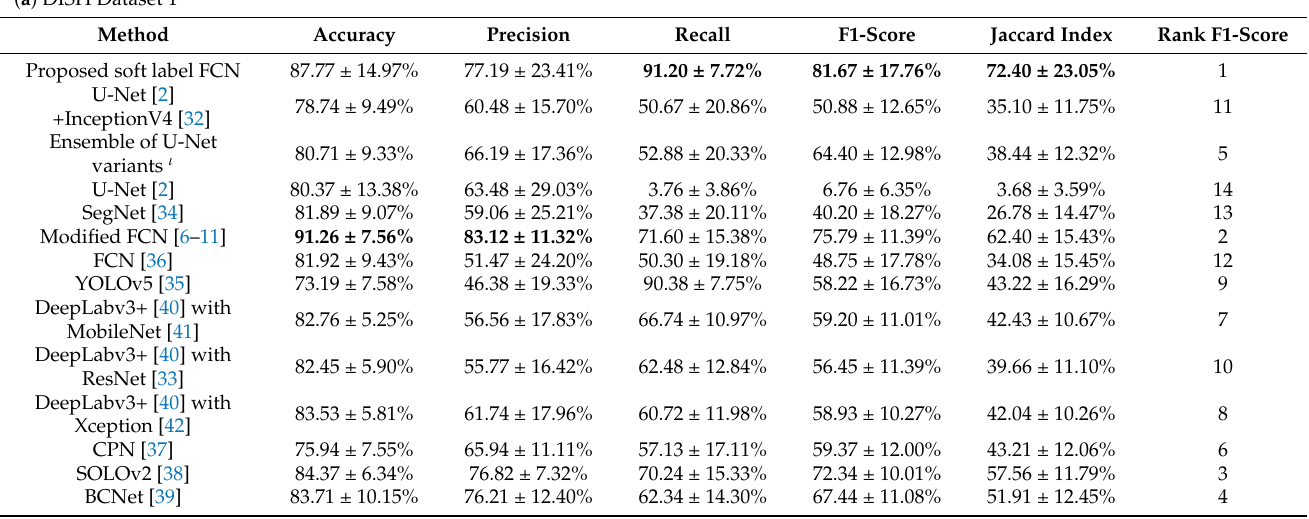
Table 3. Quantitative evaluation in segmentation of HER2 amplification in each dataset of invasive breast cancer, including ( a ) DISH breast dataset 1; ( b ) DISH breast dataset 2 and ( c ) FISH